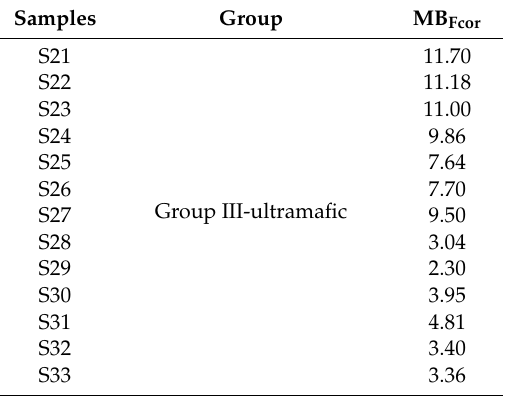
Table 5. The MB Fcor index values of the examined ultramafic rock